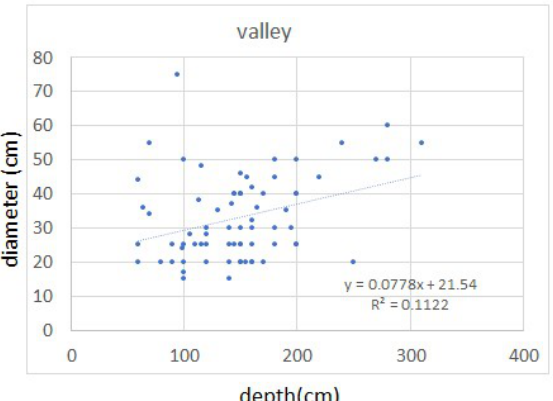
Figure 10 . Relationship between diameter and depth of roots in